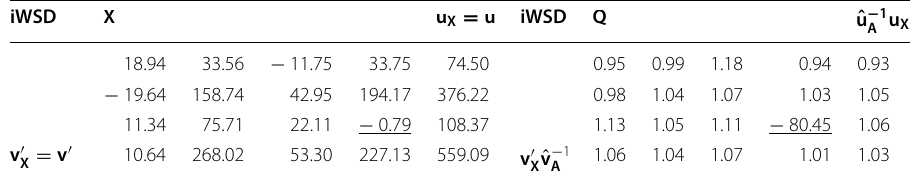
With the same location of underlined matrix elements as in Table 18